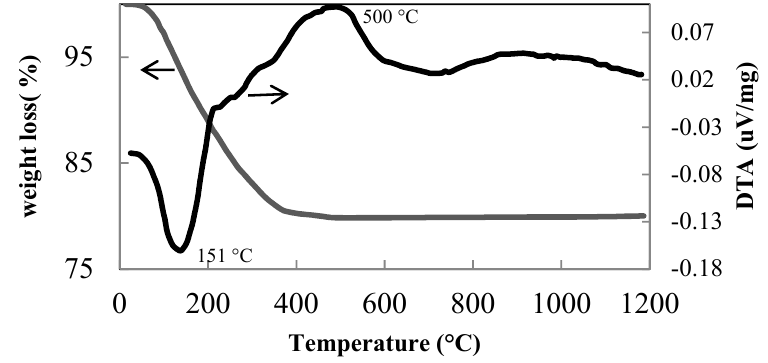
Figure 5. DTA-TGA curves of A sample reported in Table 1.